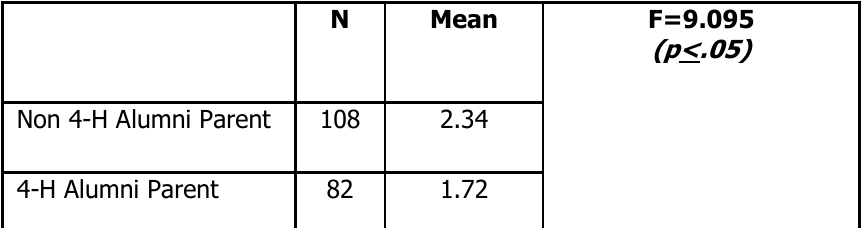
Difference of Influence of other Parents on Camp Enrollment